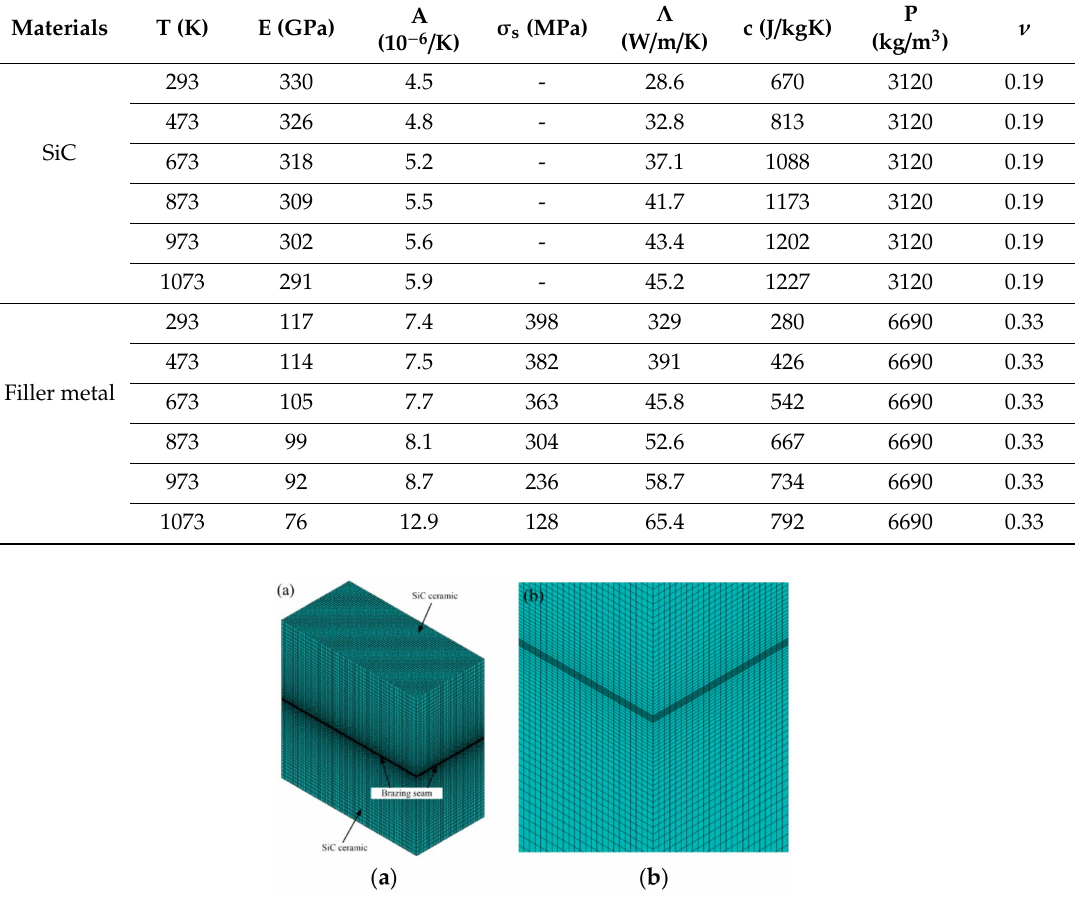
Figure 1. Finite element method (FEM) simulation meshing of SiC ceramic joint: ( a ) overall structure of the model, ( b ) local enlargement of the brazing